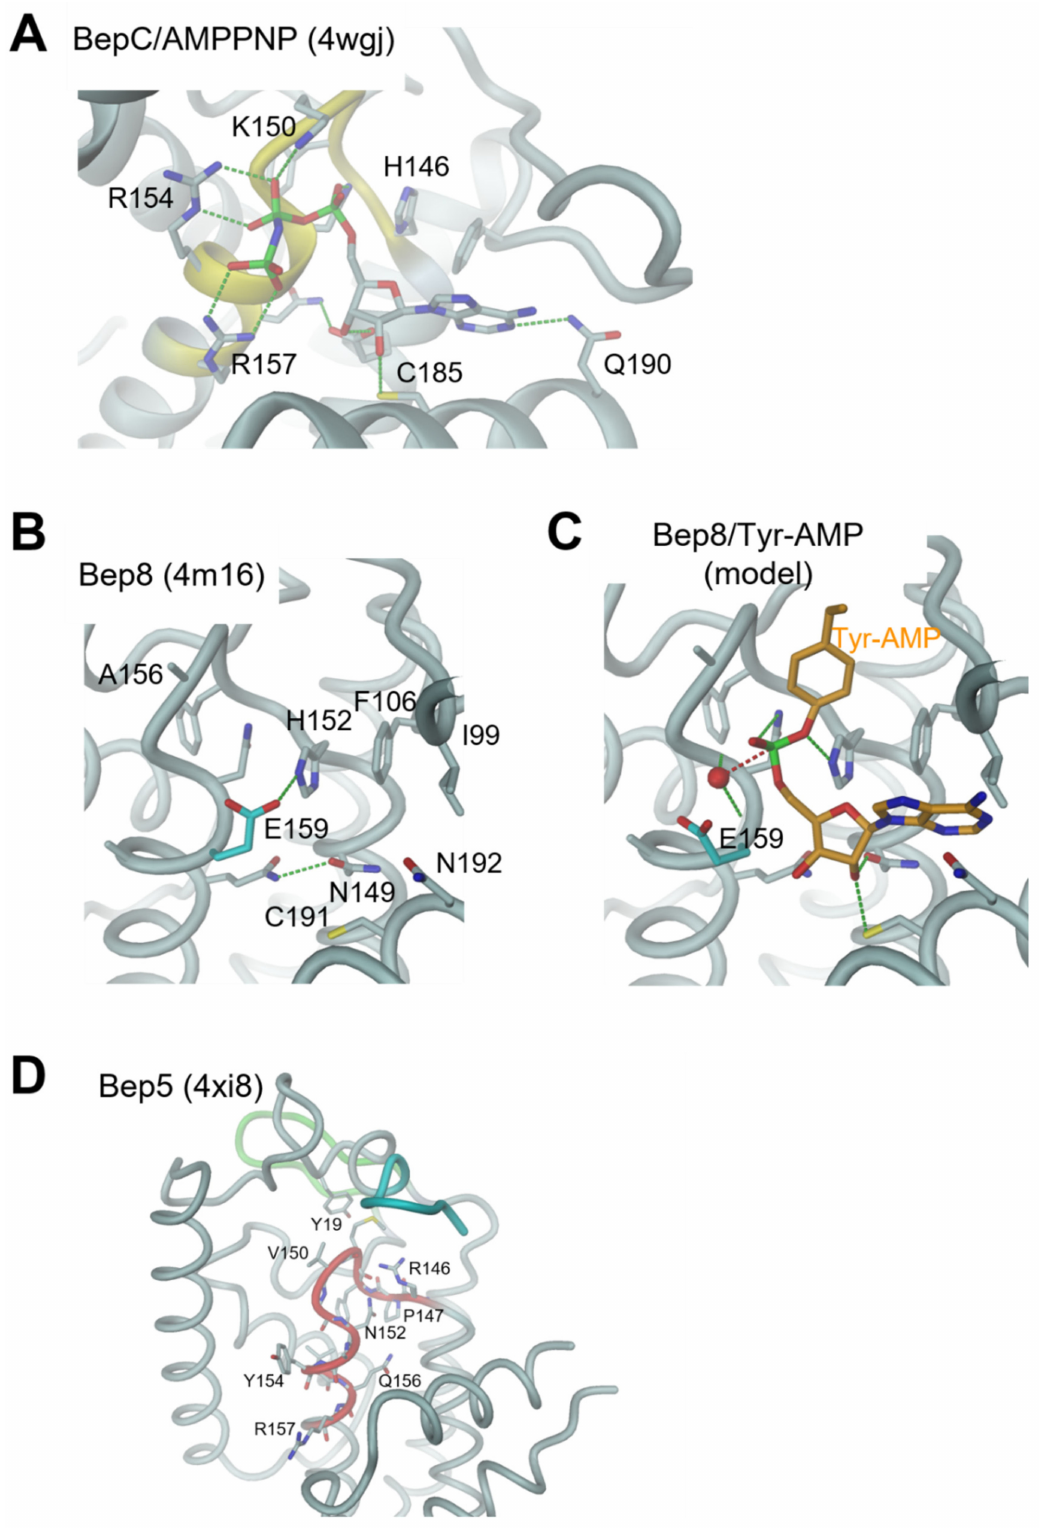
Figure 9. Structural details of the BepFIC domains. ( A ) Btr_ BepC in complex with AMPPNP. ( B ) B15_ Bep8 with E159 in position G2 highlighted in cyan. ( C ) Modeled complex of Bep8 with Tyr-AMP (orange) in a position as derived from the IbpA/Cdc42 complex 4ITR. The side-chain conformation of E159 (cyan) has been altered to allow Tyr-AMP binding. The putative hydrolytic water (red sphere) is bound to the N-terminus of α 5 and possibly to E159. ( D ) Bcl_ Bep5; note the missing flap that in other BepFIC domains is inserted between α 2 and the Bep element (green). Due to disorder, K153 is shown only up to C β . The N-termal His-tag is indicated in